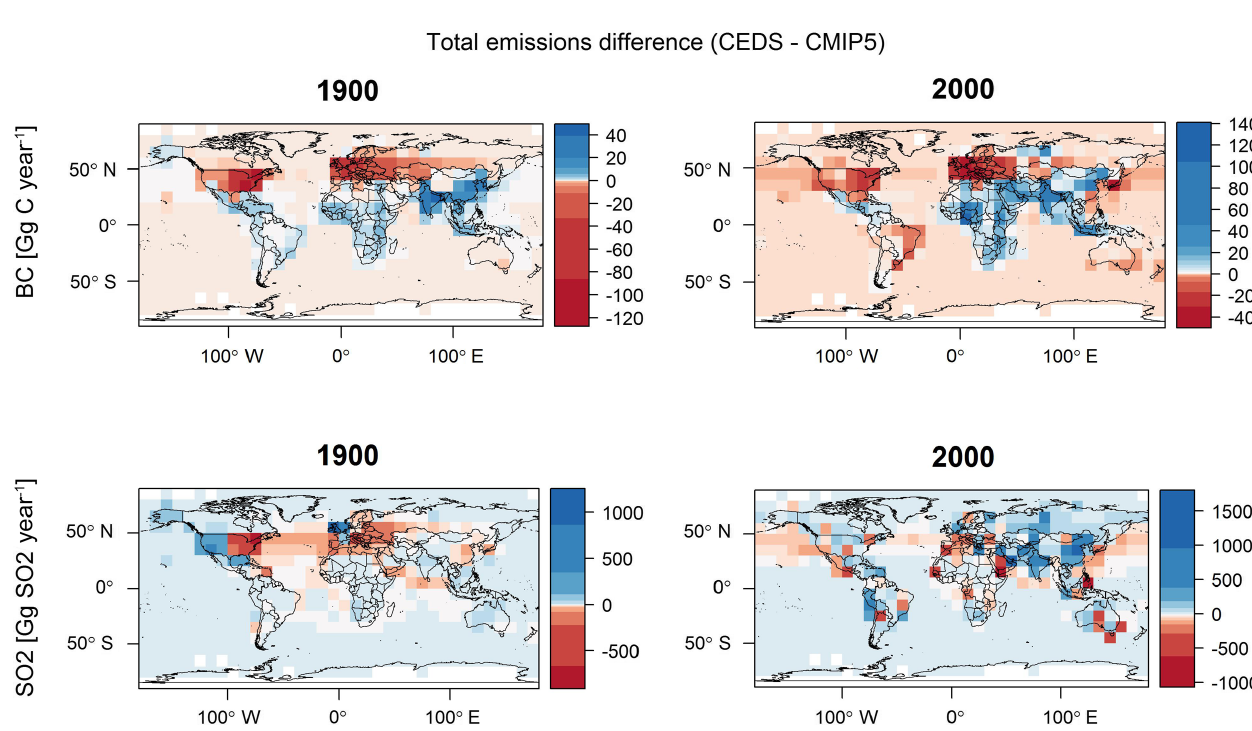
Figure 6. Total gridded CEDS emissions by emission species for 2010.